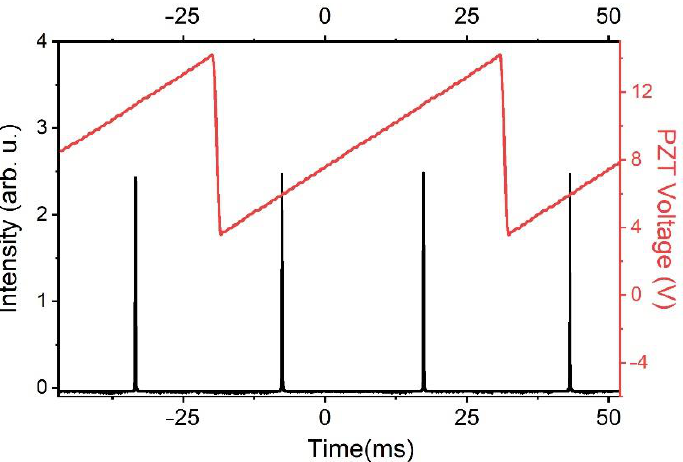
Figure 4. The signal at the output of the photodetector of the scanning Fabry – Perot interferometer (black line) and the scanning voltage of its piezo actuator (red line).